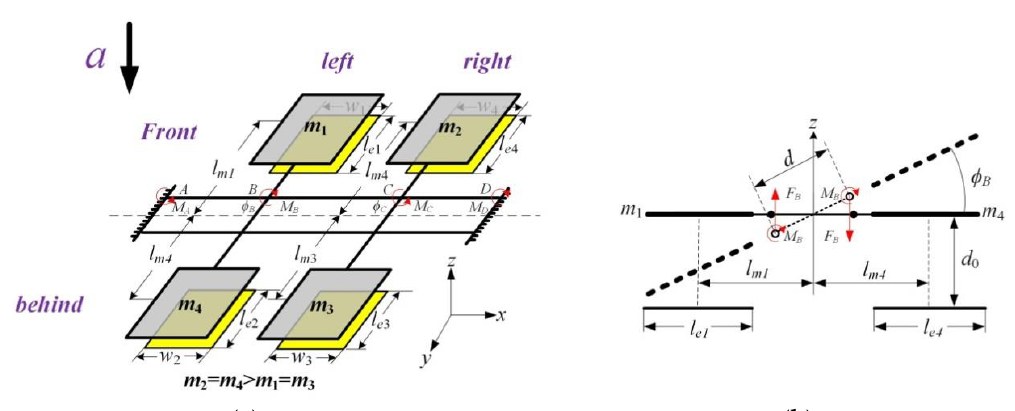
Figure 5. Mathematical model of double differential torsional capacitive accelerometer based on double-beam: ( a ) Torque model of the front torsional beam; ( b ) Mechanical model of the left torsional structure.